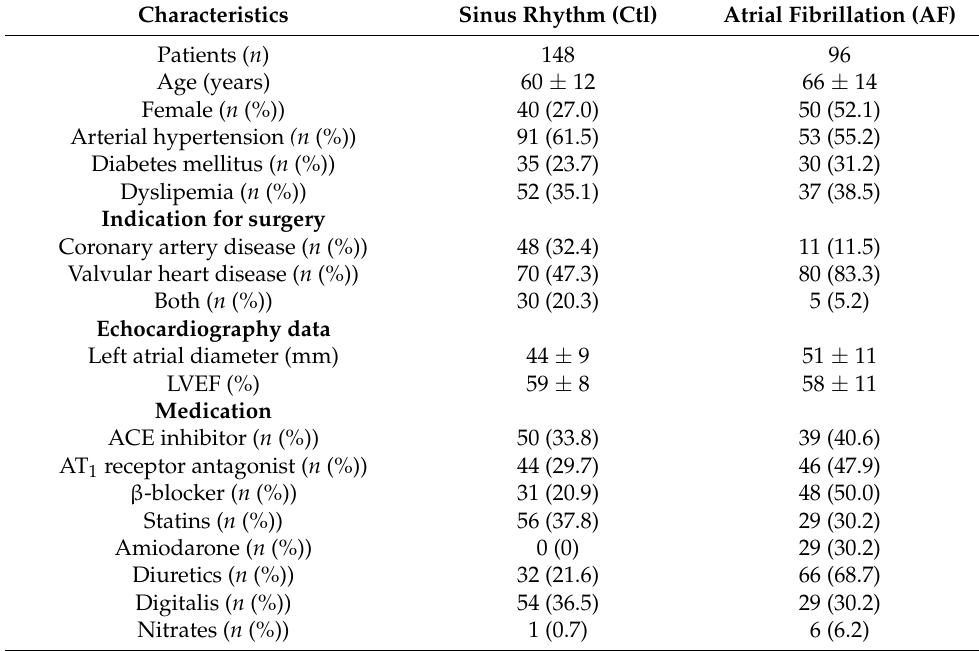
Table 1. Clinical and pharmacological details of patient included in this study. Continuous variables are presented as mean ± SD for normal-distributed data. Categorical data are given as number of patients